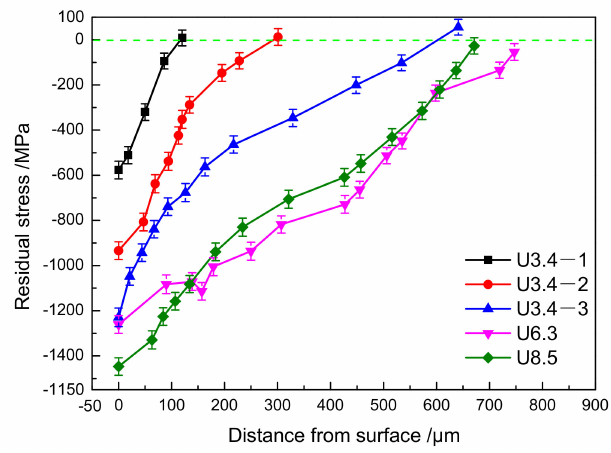
Figure 5. Compressive residual stress of 51CrV4 spring steel specimens under different treatment conditions.